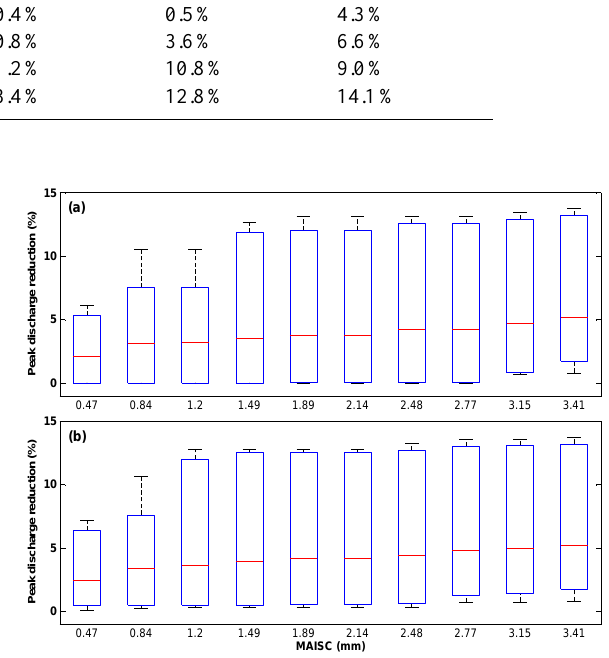
Fig. 10. Effect of MAISC and two different small-reservoirs spatial distribution in the Poyo catchment: (a) more concentred at headwa- ter areas and (b) distributed both at headwater and at middle